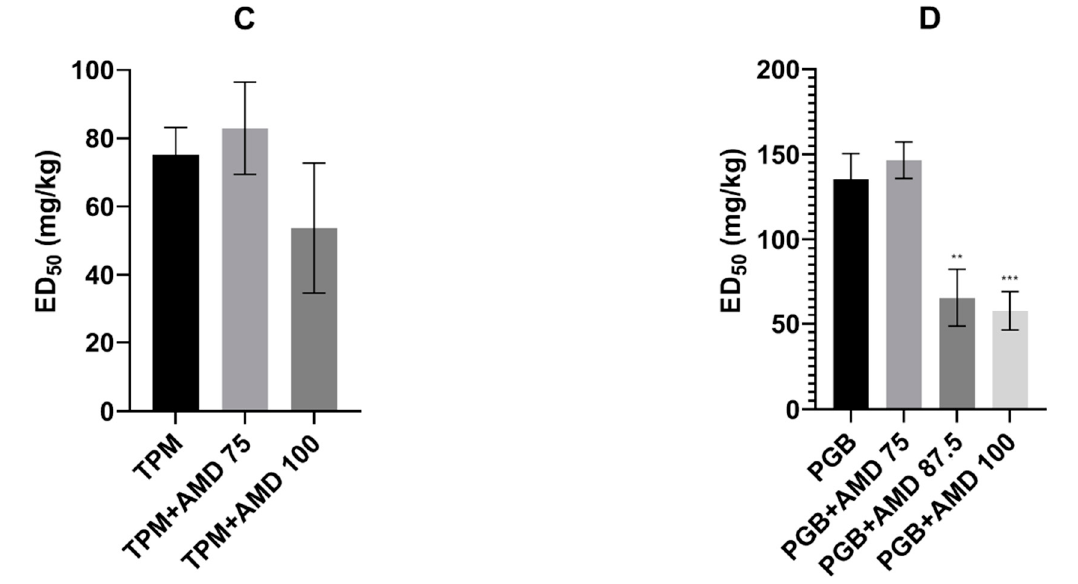
Figure 1. Effect of amiodarone (AMD) on the anticonvulsant action of ( A ). lamotrigine (LTG), ( B ). oxcarbazepine (OXC), ( C ). topiramate (TPM), and ( D ). pregabalin (PGB) against maximal electroshock-induced seizures in mice. Data are presented as median effective doses (ED 50 in mg/kg) with standard errors (SEM) that protect 50% of animals from the tonic-clonic seizures. Statistical analysis of data was performed using one-way analysis of variance (ANOVA) followed by the post hoc Tukey test. * p < 0.05, ** p < 0.01, *** p < 0.001 vs. control group.